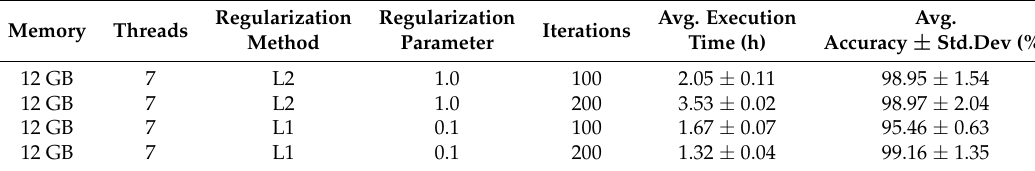
Table 7. SVM classifier performance on the Breast Invasive Carcinoma (BRCA) dataset with ten different randomly generated training (80%) and test (20%)